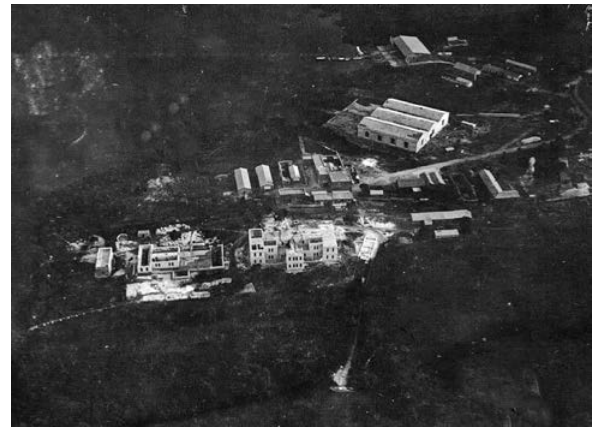
Figure 2. View of the complex under construction (1918 c.a)